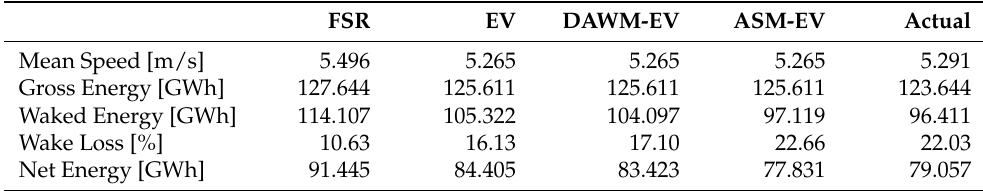
Table 2. Comparison of actual energy and calculated energy. FSR